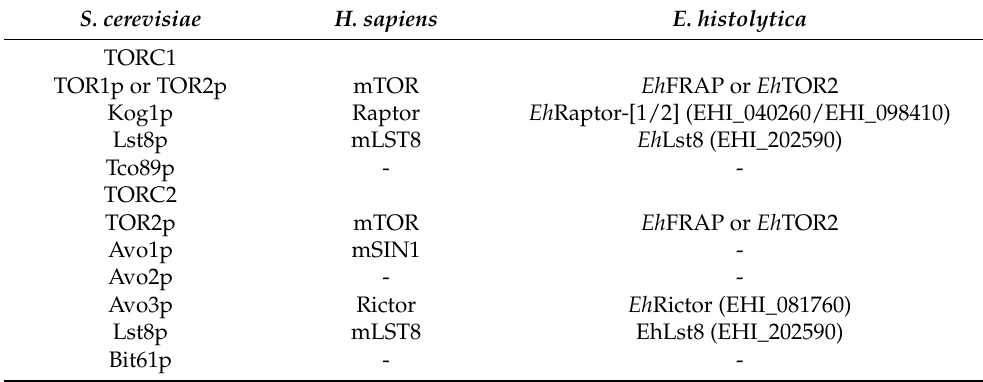
Table 4. Components of S. cerevisiae TORC1 and TORC2 and their homologs in humans and amoeba. S. cerevisiae H. sapiens E. histolytica